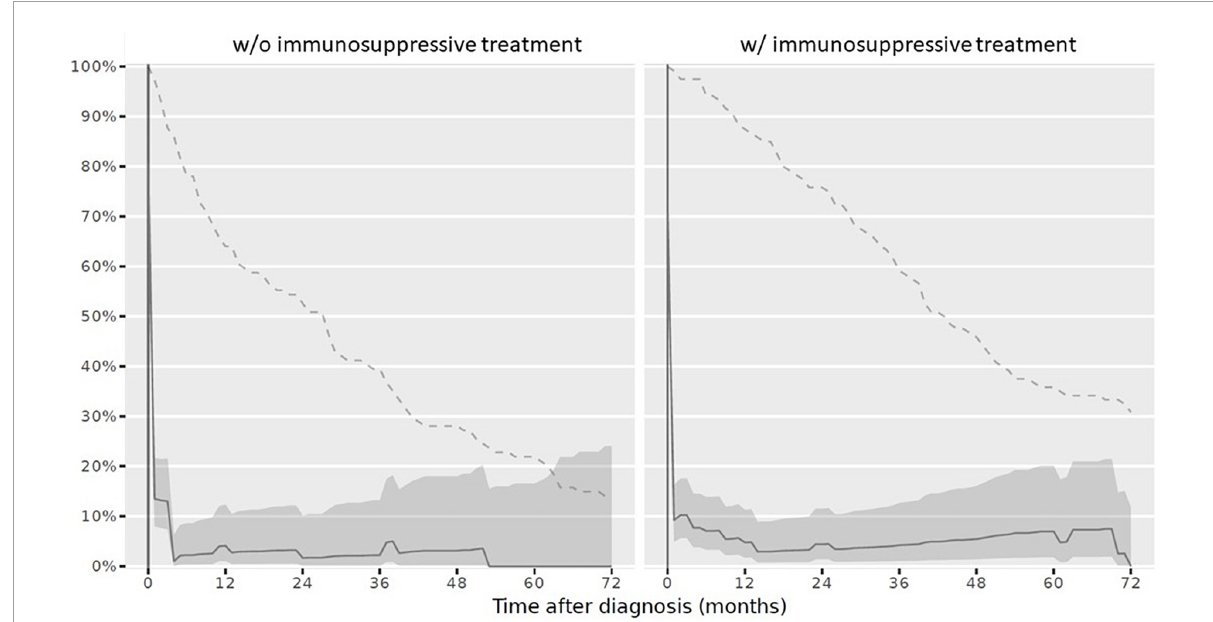
FIGURE2 Complete overall vaccination status in children after PRD diagnosis according to the Swiss national vaccination schedule and specific additional PRD vaccination recommendations. Legend: y-axis Completeness (% patients vaccinated completely, solid line with 95% confidence interval), x-axis Sample size (% patients available, dashed line). PRD, pediatric patients with rheumatic inflammatory diseases. w/o, Without immunosuppressive treatment w/ with immunosuppressive treatment.